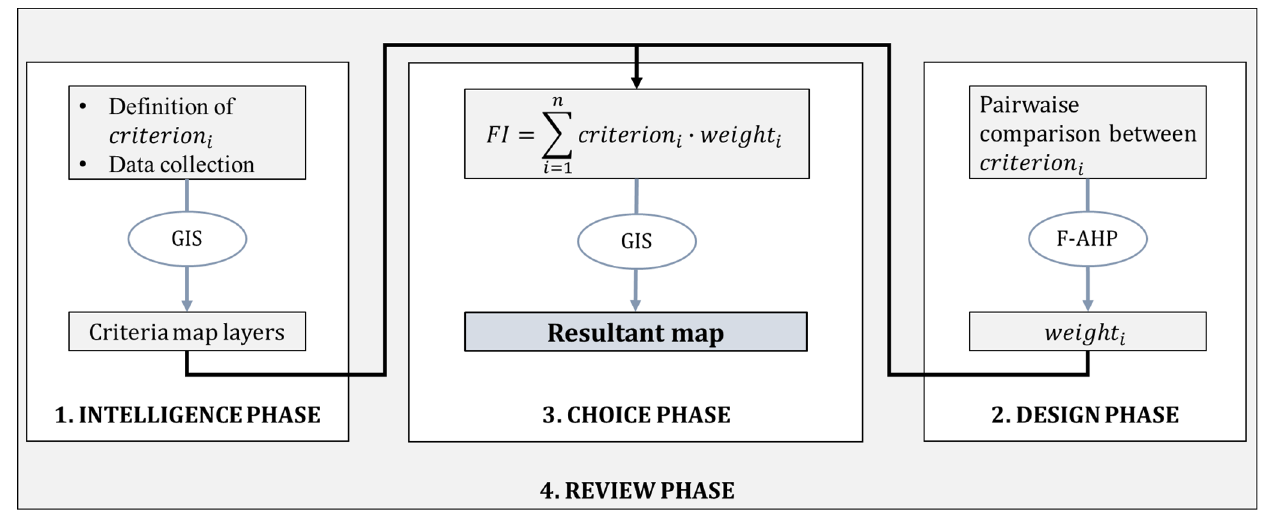
Figure 4. Flowchart of decision-making process related to identification of potential e-roads.